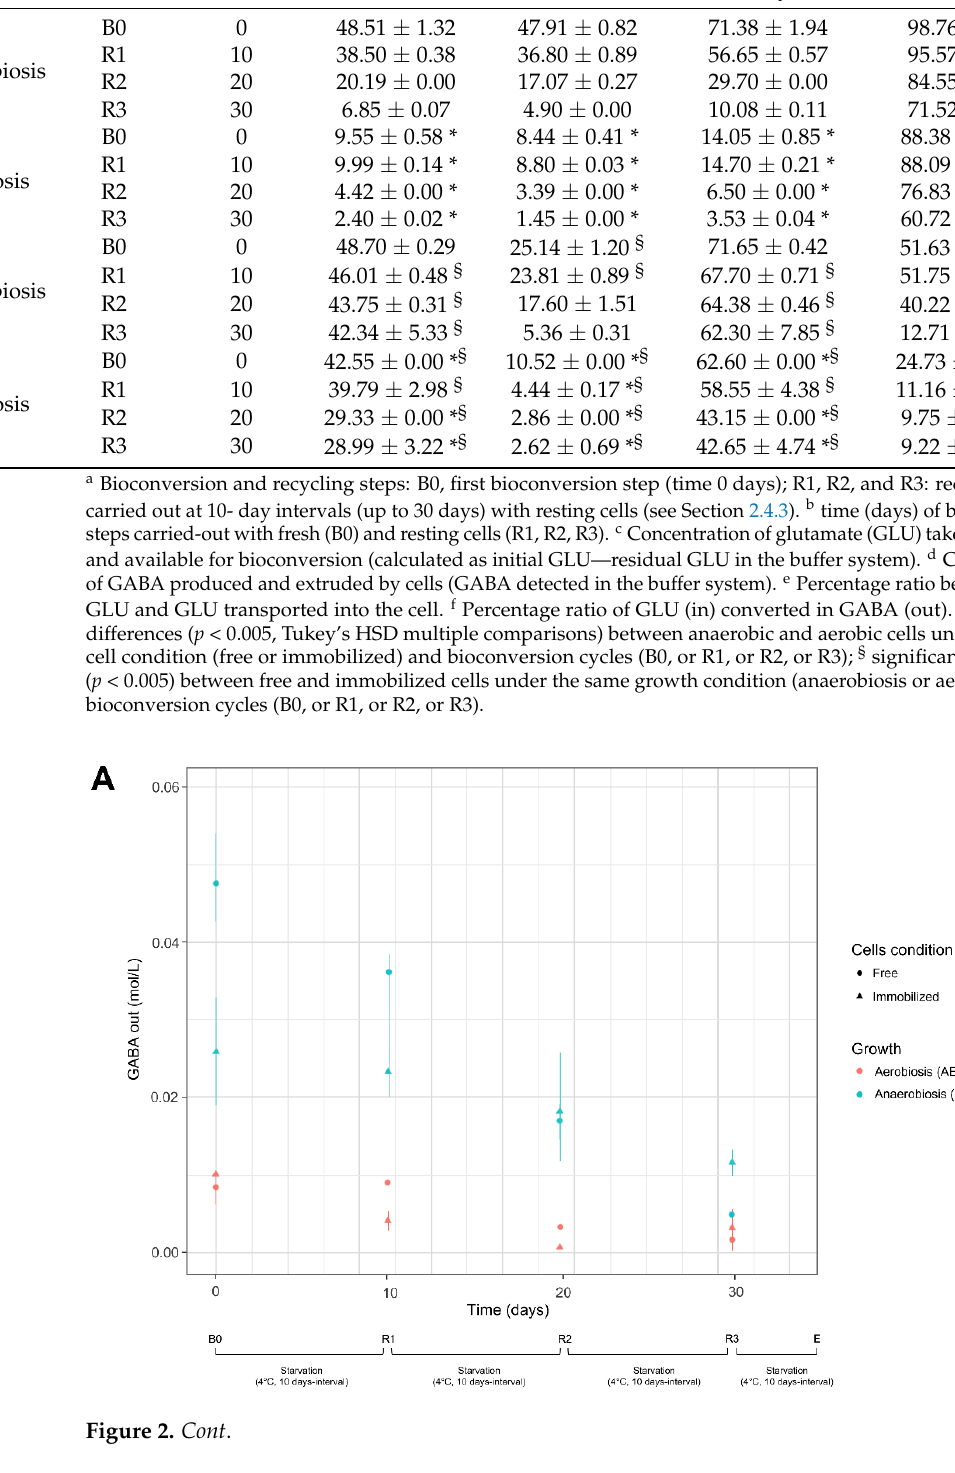
Figure 2. GABA produced (mol/L) and extruded by cells (panel A ) and fraction of glutamate (ex- pressed as a ratio between initial GLU and GLU transported into the cells) available for bioconver- sion (panel B ). Cell condition (free, immobilized) and growth (aerobiosis, anaerobiosis) used for biocatalysis are described in sections 2.4.1 and 2.4.2. Bioconversion and recycling steps: B0, first bi- oconversion step (time: 0 days) carried out with fresh cells; R1, R2, and R3: recycling steps carried- out at 10 day interval (up to 30 days) with resting cells (see Section 2.4.3); E, end of starvation and bioconversion steps.